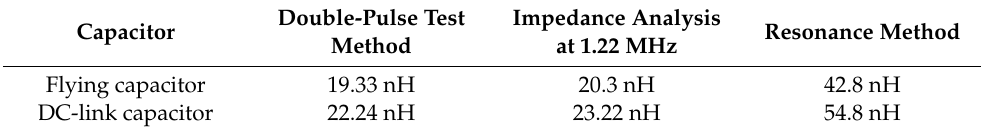
Table 5. The comparison of different stray inductance measuring methods for DC-Link capacitor and flying capacitor.